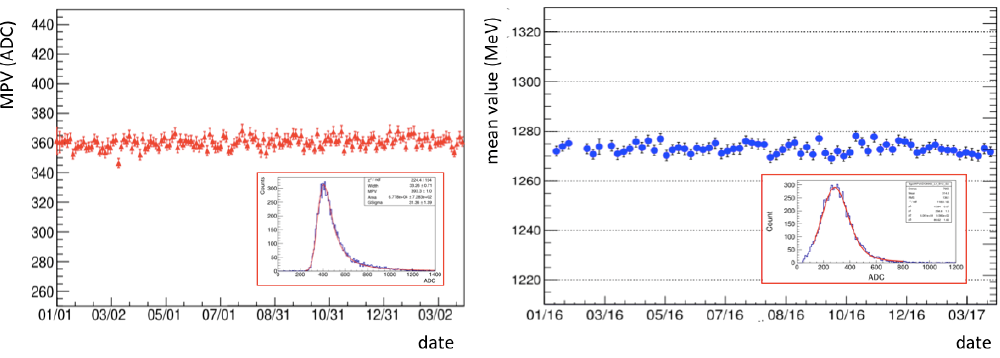
Figure 4. Left panel: the deposited energy in PSD for minimum ionizing protons is fitted with the convolution of a Landau function with a Gaussian one (insert). The Most Probable Value (MPV) s shown as a function of time. Right panel: similar plot for minimum ionizing helium nuclei in BGO (the mean value of the deposited energy is displayed versus time instead of